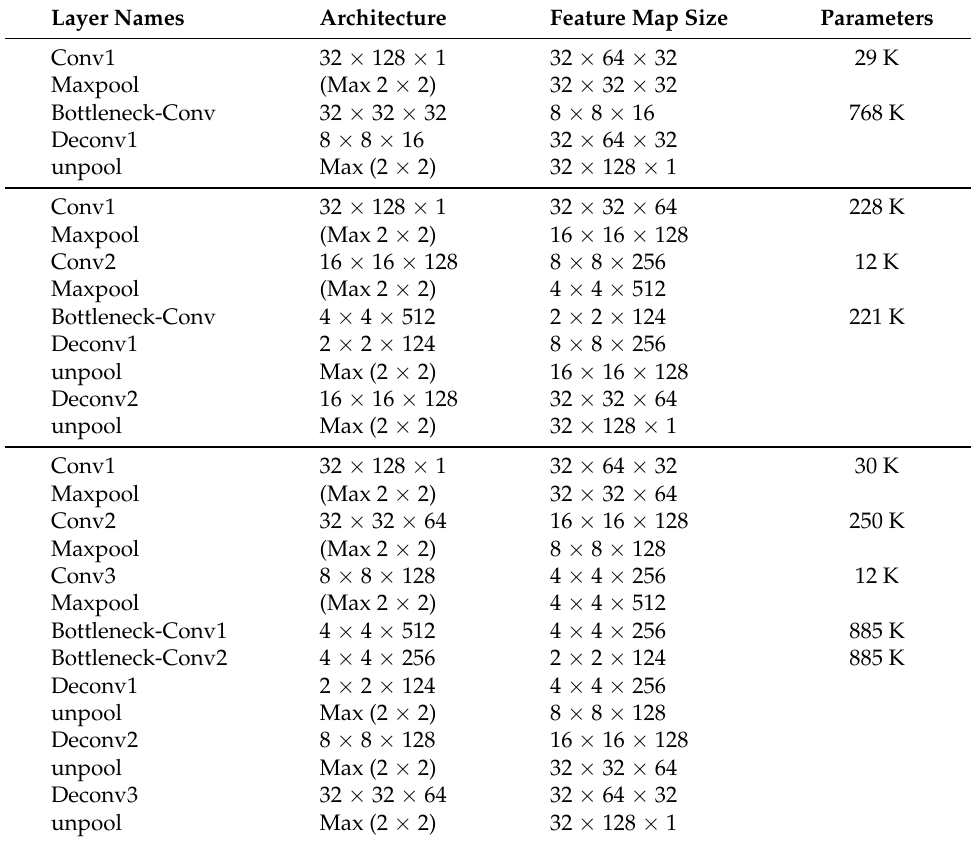
Table 2. Proposed method detailed